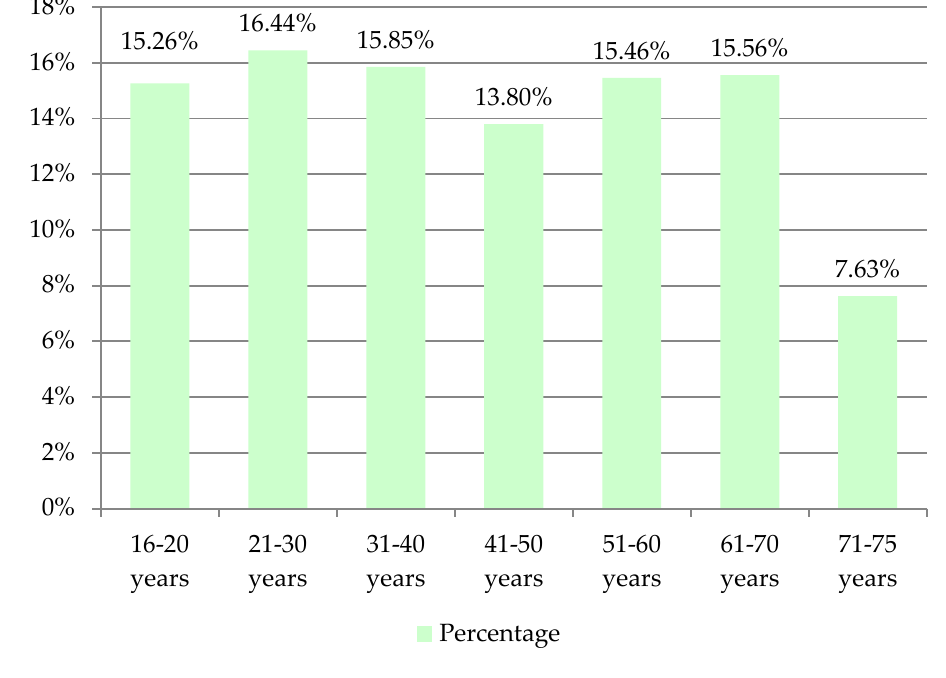
Figure 2. The age of the respondents in %.